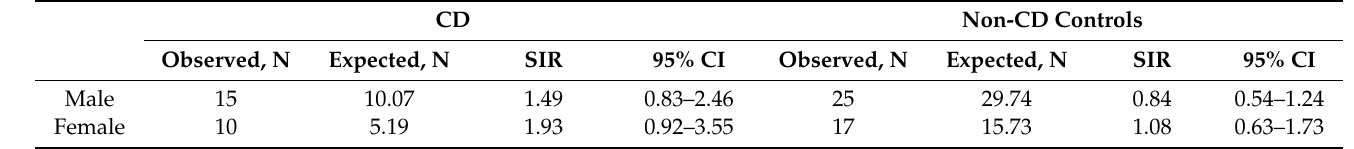
Table 2. Standardized incidence ratio of colorectal cancer in CD